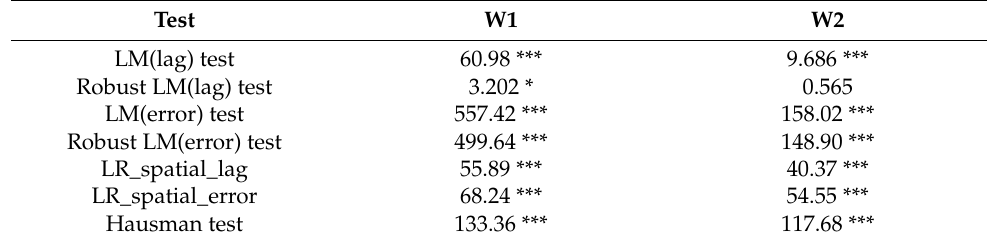
Table 3. Identification test of spatial panel econometrics